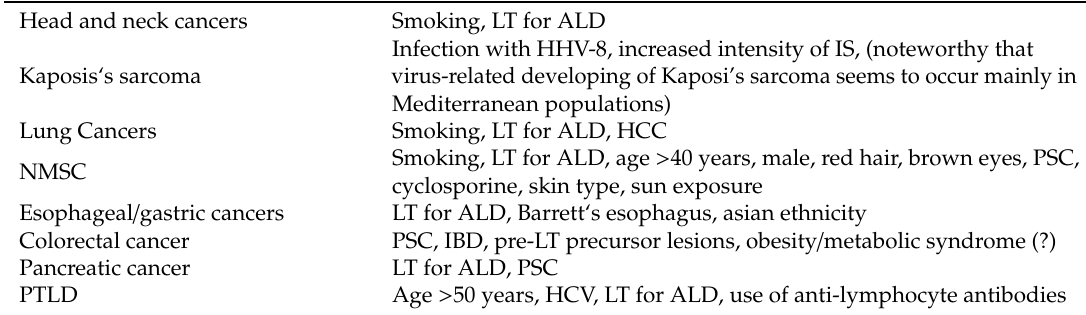
Table 3. Statisticallyrelevantriskfactorsfordenovocancerdevelopment, basedoncurrentliterature[18,40,44]. Head and neck cancers Smoking, LT for